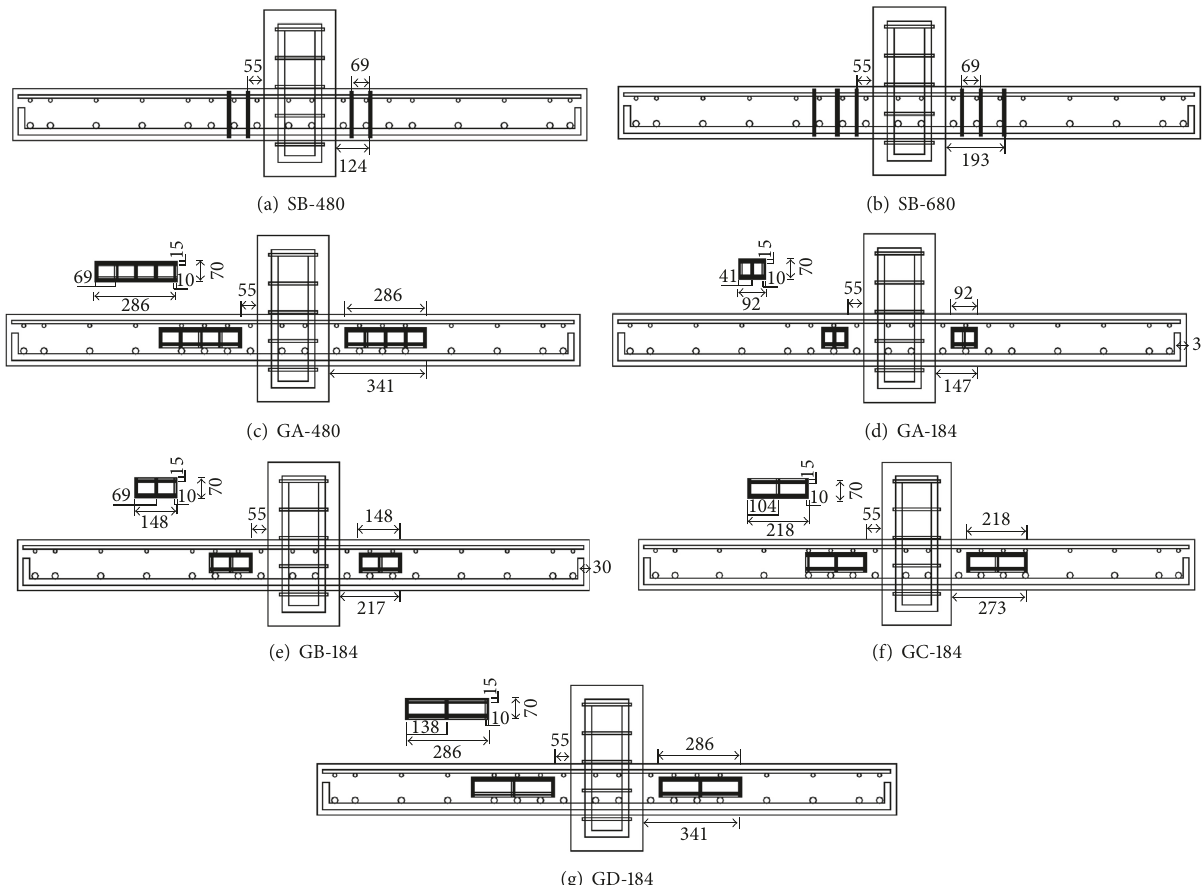
Figure 5: Arrangement of shear reinforcement in the specimen (dimensions in mm).